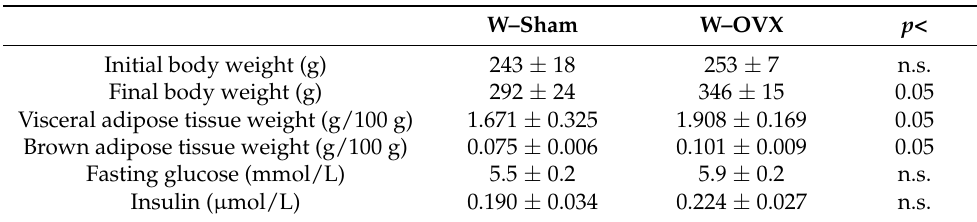
Table 1. Basal metabolic and morphological parameters in ovariectomized (W–OVX) rats compared to sham-operated control rats